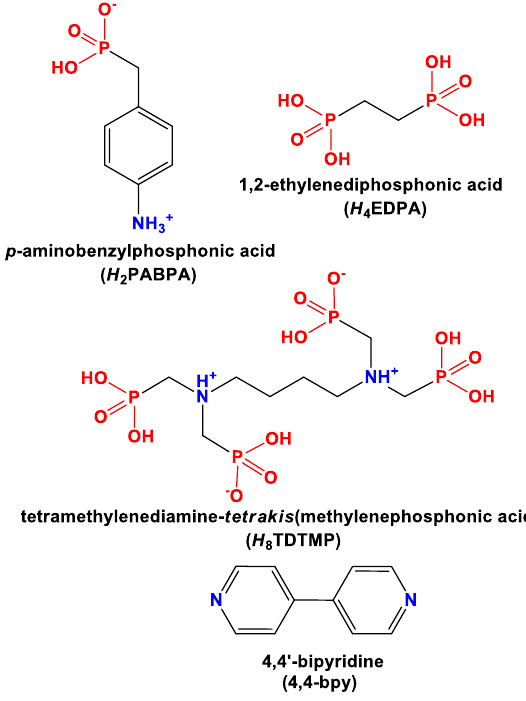
Figure 1. Phosphonic acids and N-heterocyclic ligand used in this paper. Phosphonato groups are highlighted in red, and N groups in blue. Amine-containing ligands are shown in their zwitterionic form.